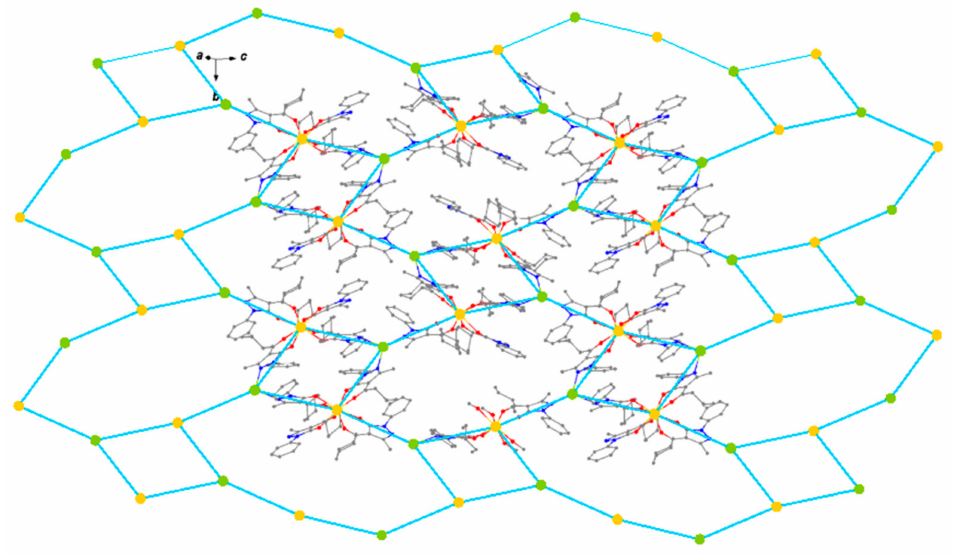
Figure 3. Crystal packing of [AgGd(Q cy ) 4 ] n 8